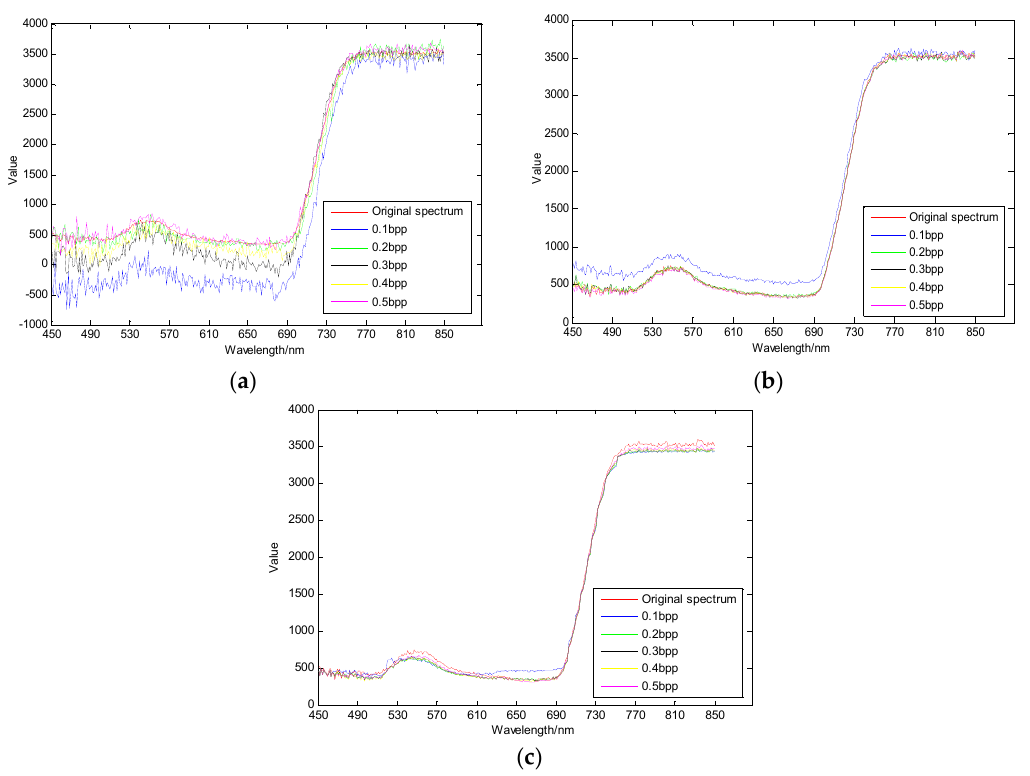
Figure 10. Comparison of reconstructed spectral curves of ROI1. ( a ) OMP; ( b ) GPSR; ( c ) AGDCS.